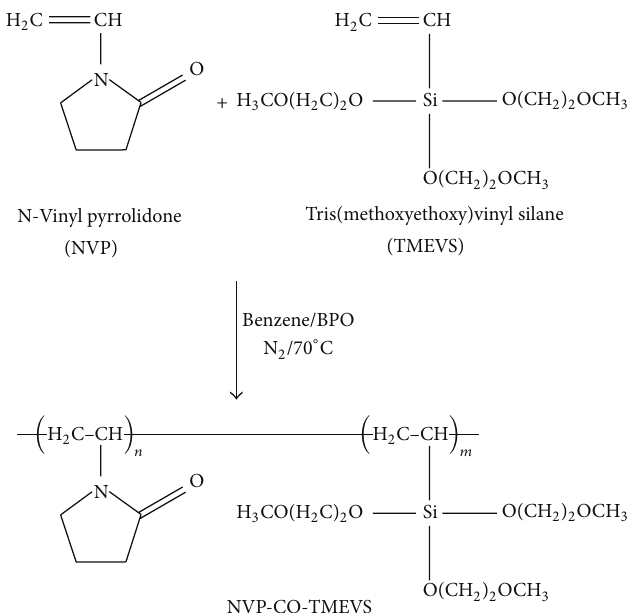
Scheme 1: Schematic illustration of the process formation of NVP-CO-TMEVS copolymer from NVP and TMEVS as